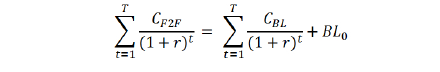
Figure 2. Equation for the PV break-even calculation where C=cost of teaching method, r=discount rate, t=number of years, and BL 0 =cost of transitioning to BL.